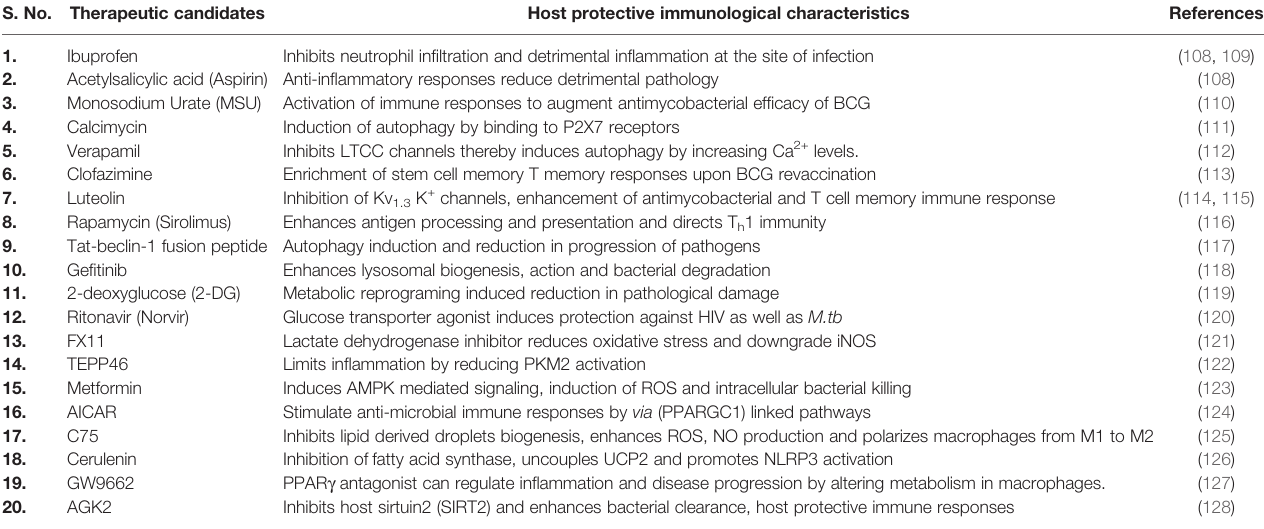
TABLE 3 | Potential host directed immunotherapeutic approaches against M.tb